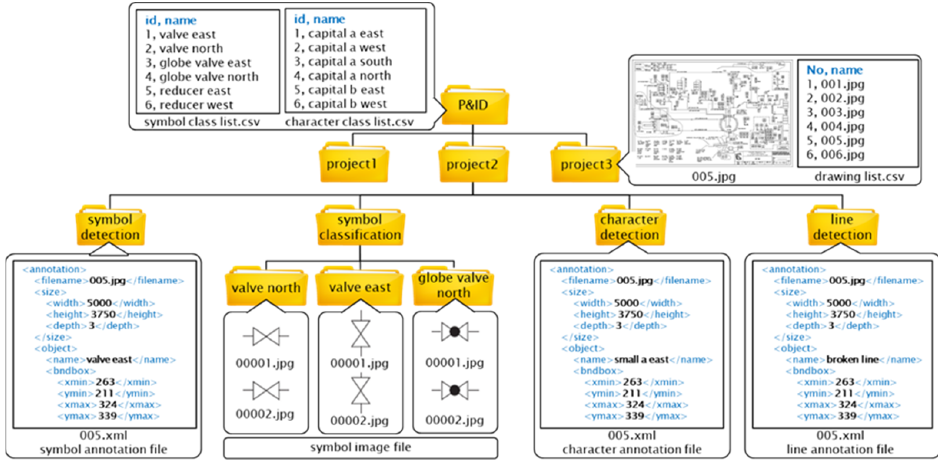
Figure 1. Training data structure used for P&IDs object recognition.